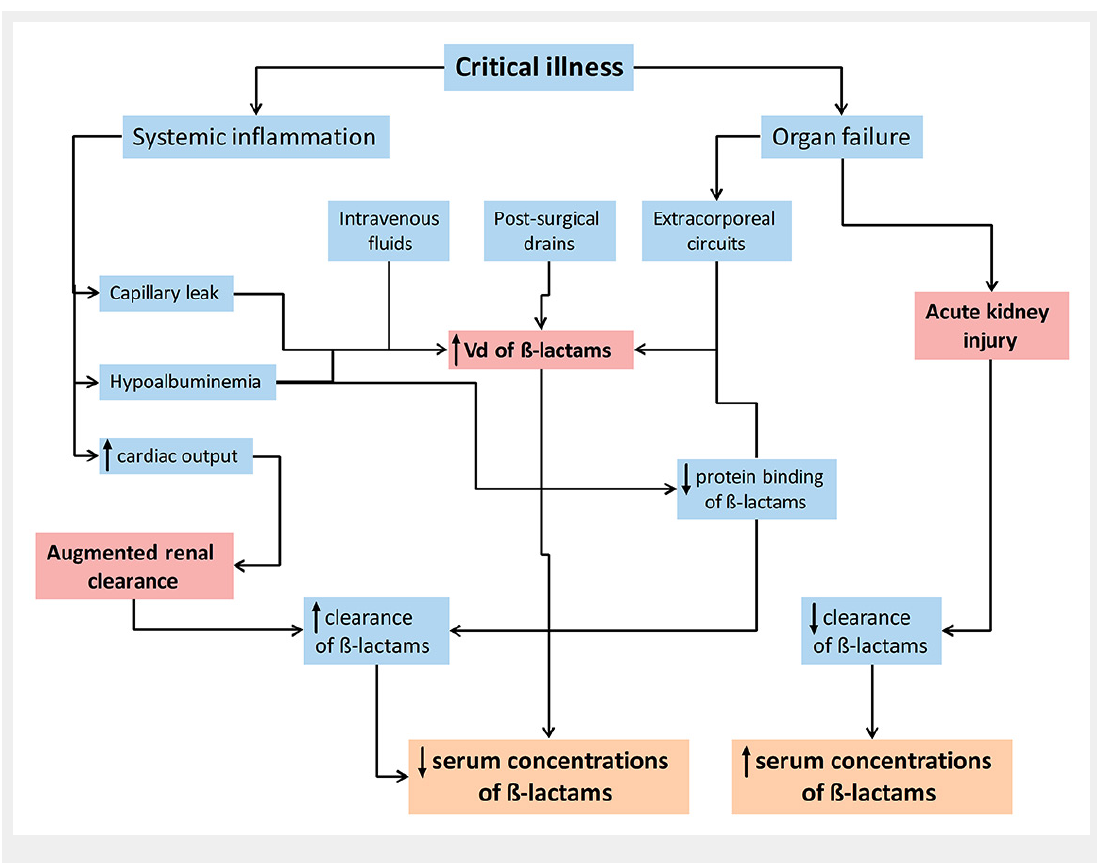
Figure 2 Pathophysiological alterations in critically-ill patients and their predicted influence on β-lactam pharmacokinetics. Vd = volume of